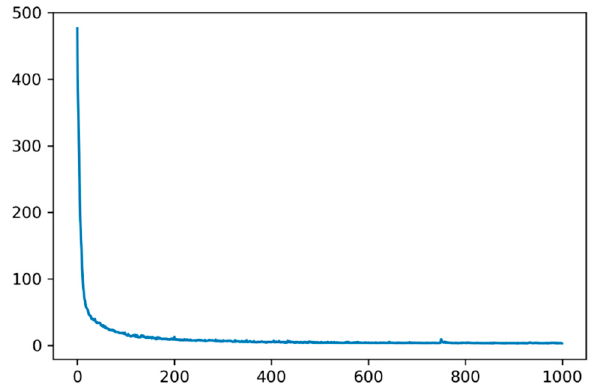
Figure 16. Predicted population density loss as a function of the epoch number or training time.